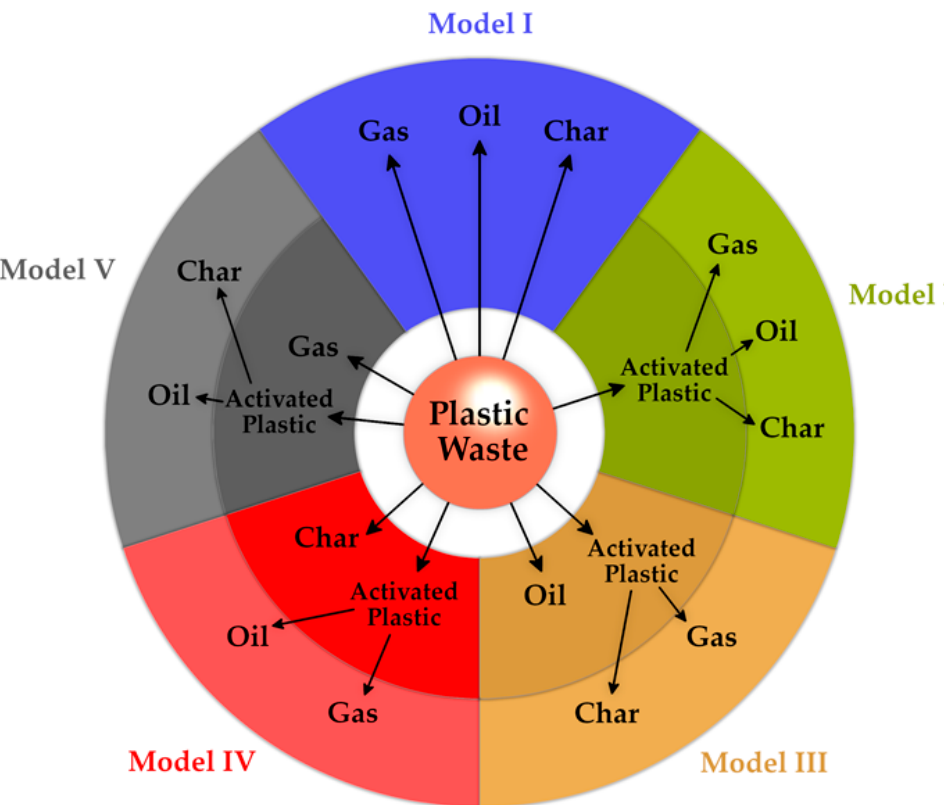
Figure 8. Five different proposed scenarios for the global kinetic model of plastic waste (PE + PS) pyrolysis (adapted from [118]).